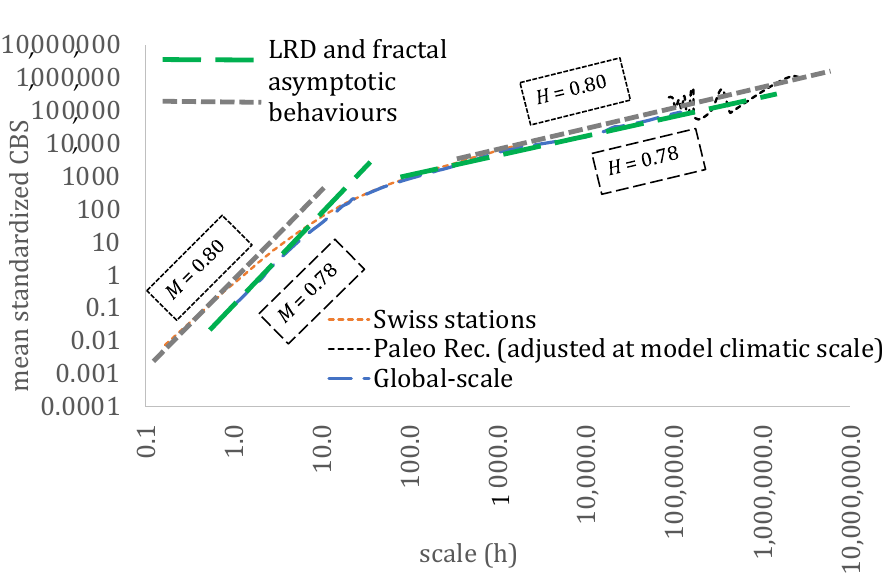
Figure 7. The mean standardized CBS for the analysis by Dimitriadis et al. [6] (daily and hourly resolution), for the Swiss dataset (10 min resolution) and for the paleoclimatic reconstructions (annual resolution).